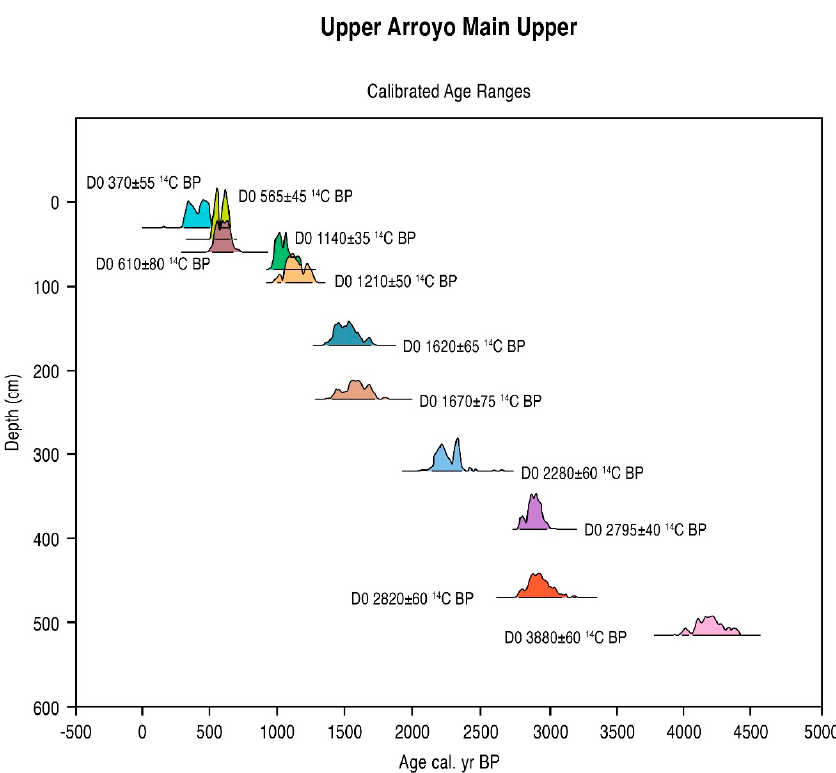
Figure 8. Age–depth graph with the 2-Sigma plot for the Upper Arroyo main sequence, upper part.